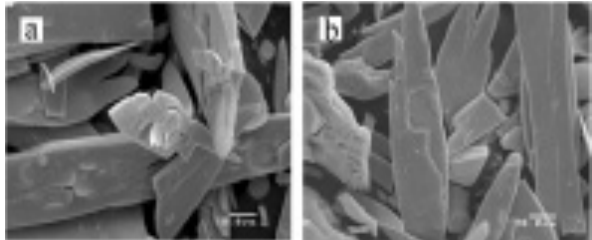
Fig. 3. SEM micrographs of the calcined samples. 5 minute magnetic stirred and calcined at 700 o C (a),